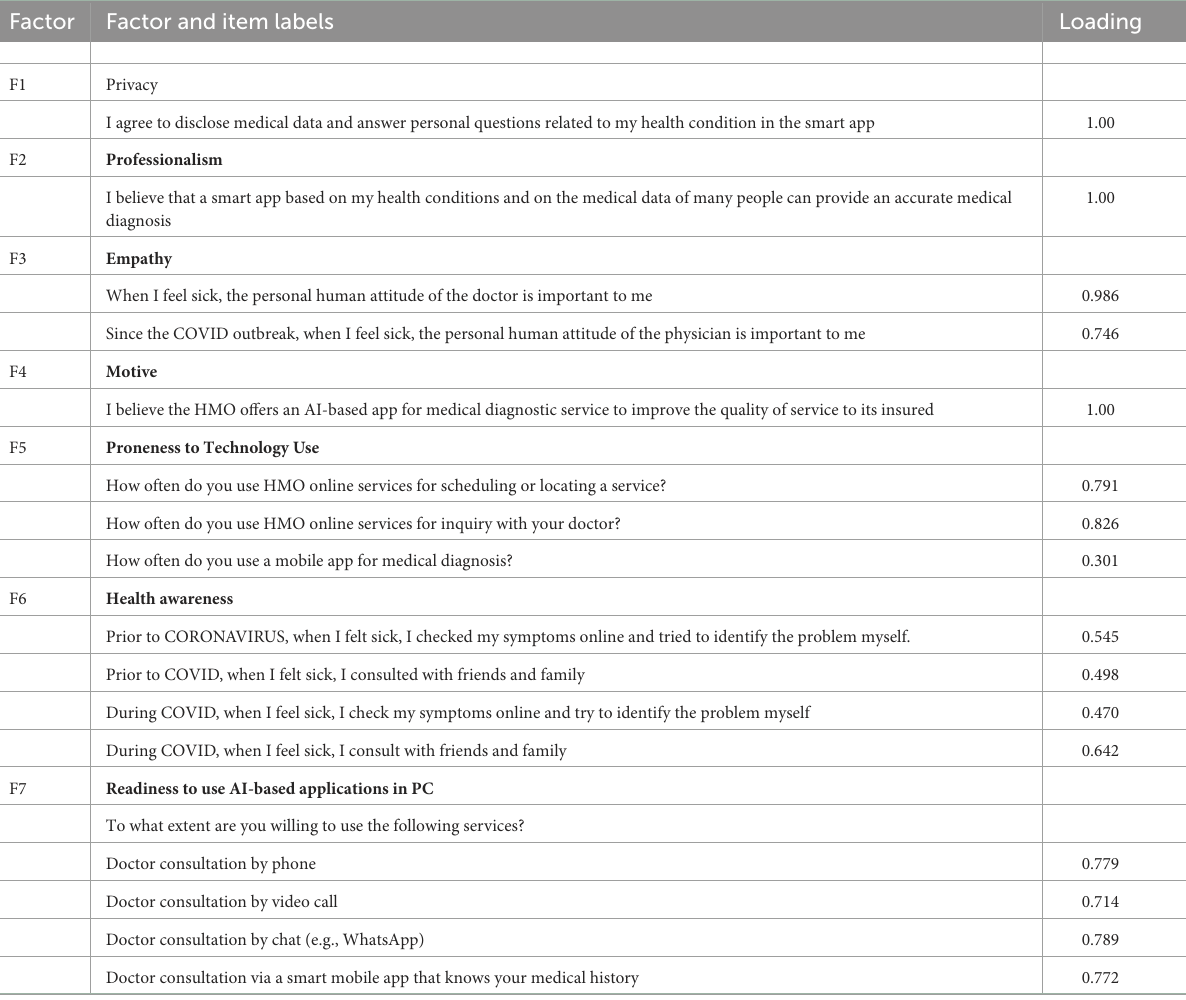
TABLE 1 CFA results, factor loadings, and goodness of fit, with item labels. Factor Factor and item labels Loading